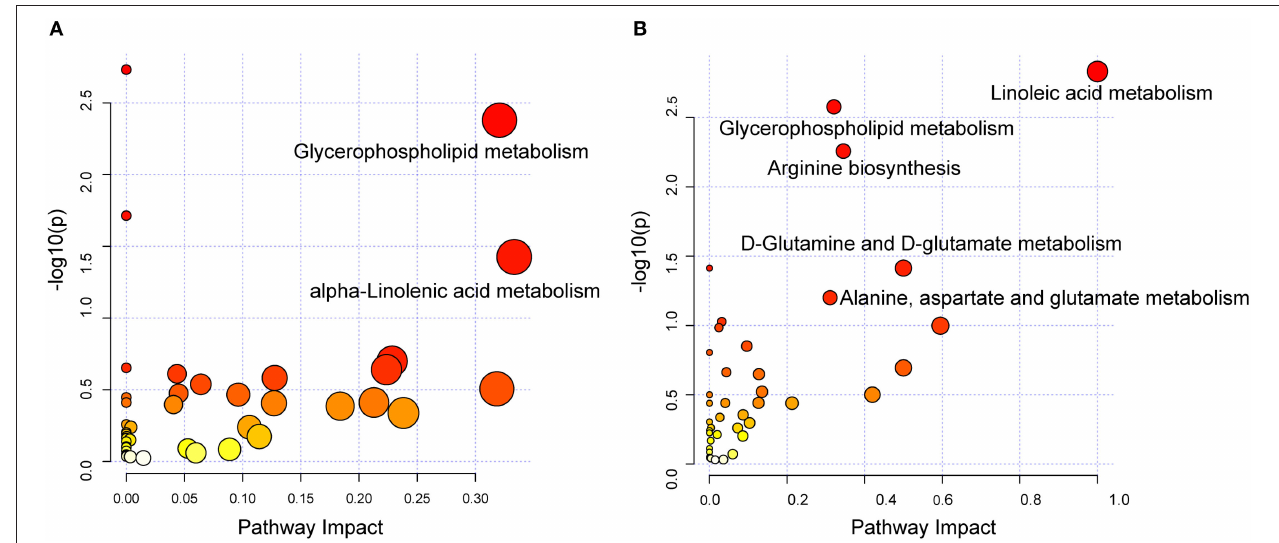
FIGURE 4 | Dysregulated pathway observed in DCM and ICM. Dysregulated pathways involved in the pathogenesis of patients with DCM (A) or ICM (B) . Significant pathways ( P < 0.05) were highlighted.